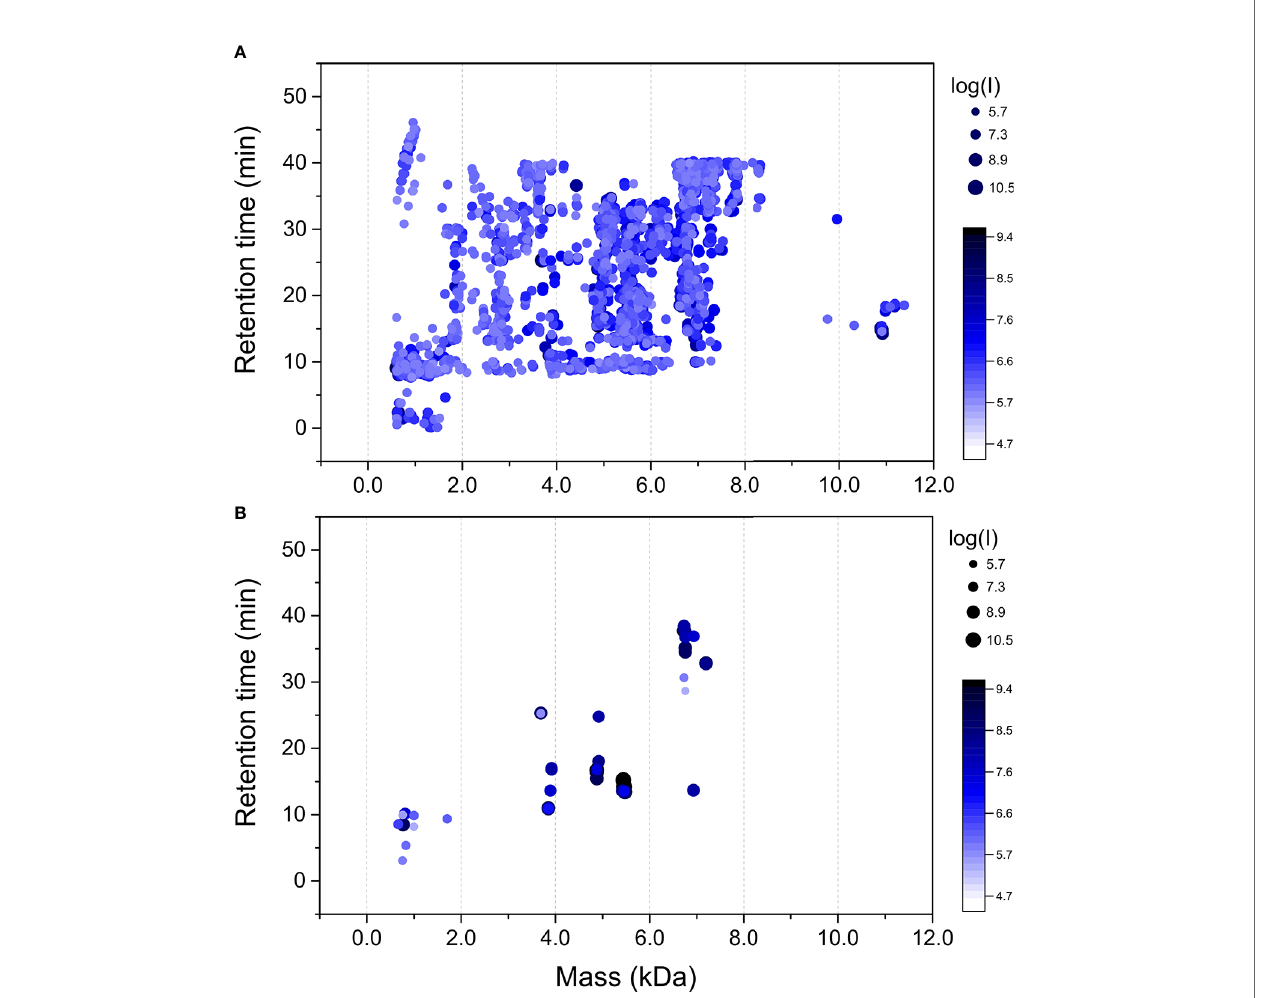
FIGURE 2 | Mass maps of precursor ions identi fi ed in Acanthoscurria rondoniae peptidomic venom fraction after Progenesis QI for proteomics raw data processing. (A) 2,800 precursor ions obtained after manual fi ltering and clustering of redundant ions. (B) Precursor ions corresponding to the 18 mature toxins validated in A. rondoniae venom in different charge